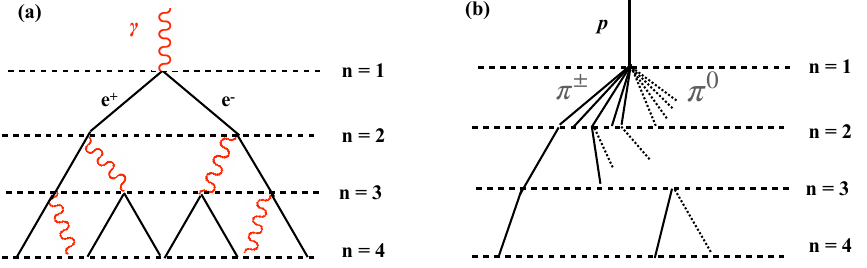
Figure 4. Schematic view of an e.m. cascades ( a ), and of a hadronic shower ( b ). In the hadron shower, dashed lines show π 0 which do not re-interact but decay, producing e.m. Figura 5.5: Grafici del secondo ordine in ↵ : in alto, di↵usione e  e  ; in basso di↵usione e + e  .